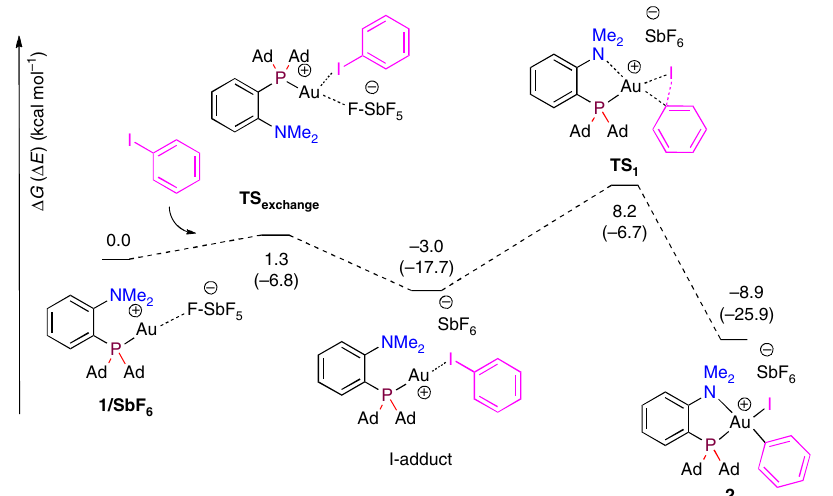
Fig. 5 Computed energy pro fi le for the oxidative addition of PhI to gold. Energy pro fi le computed at the B97D(SDM-DCM)/SDD+f(Au), SDD(I,Sb),6-31G** (other atoms) level of theory taking into account the SbF 6 – counter-anion and dichloromethane effects with Universal Solvation Model based on solute electron density (SMD model). Electronic energy ( Δ E ) including ZPE correction into brackets and Gibbs free energy ( Δ G ) in kcal mol −